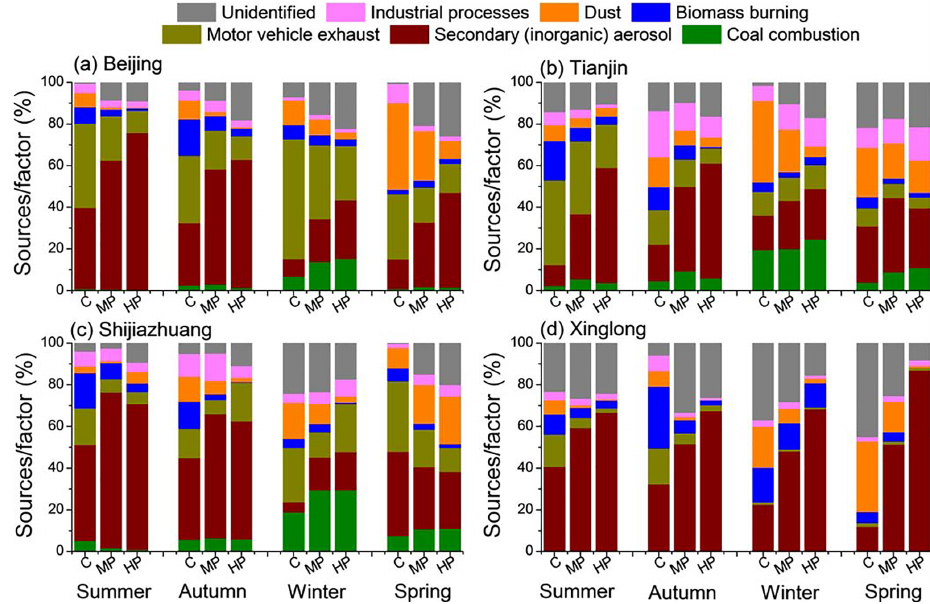
Figure 9. Fractional contributions of source factors to the PM 2 . 5 masses at different pollution levels during each season in Beijing (a) , Tianjin (b) , Shijiazhuang (c) , and Xinglong (d) . C, MP, and HP represent clean days (PM 2 . 5 < 75µgm − 3 ) , moderate pollution days (75 ≤ PM 2 . 5 < 150µgm − 3 ) , and heavy pollution days (PM 2 . 5 ≥ 150µgm − 3 ) ,